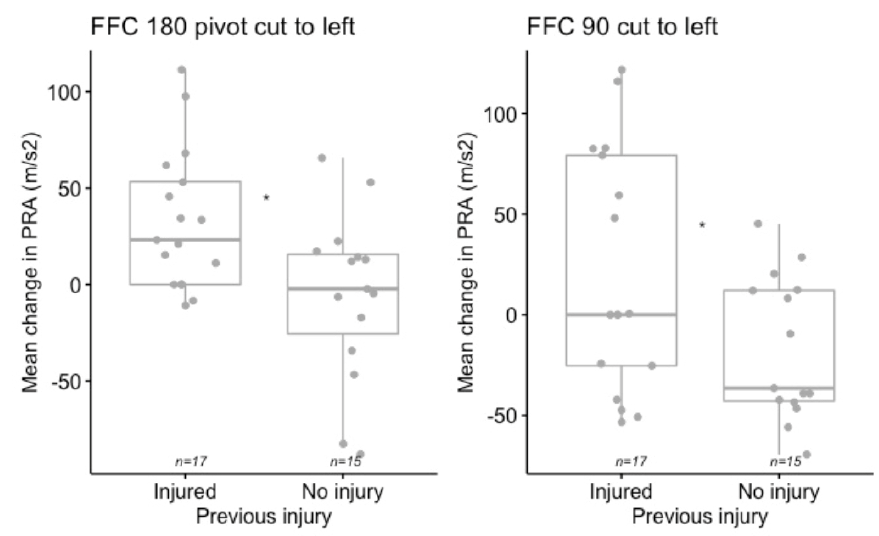
Figure 3. Boxplots of differences in peak resultant acceleration (PRA) change between previously